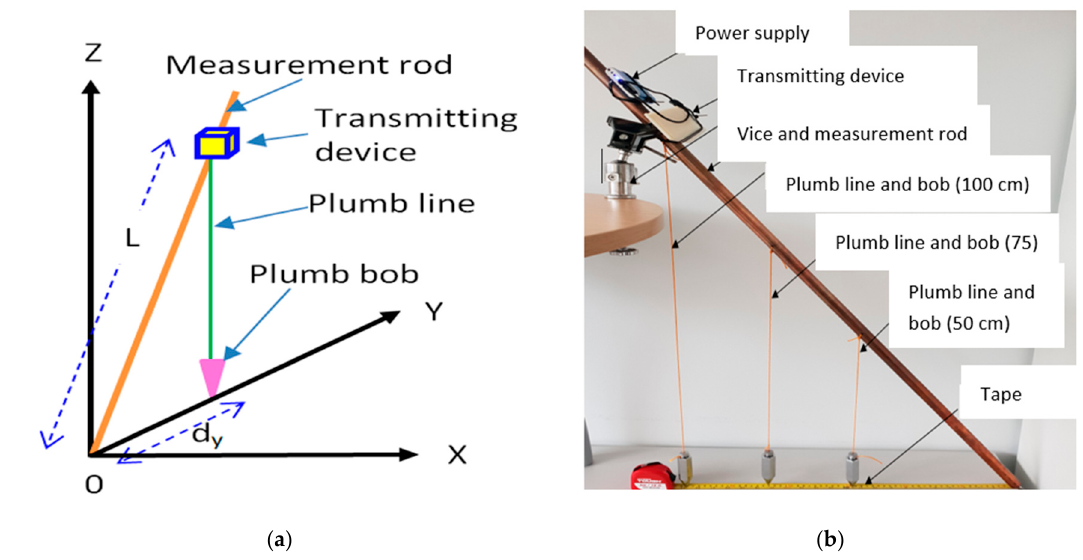
Figure 5. Test measurement apparatus ( a ) schematic diagram with only one of the three plumb bobs shown; ( b ) actual apparatus.